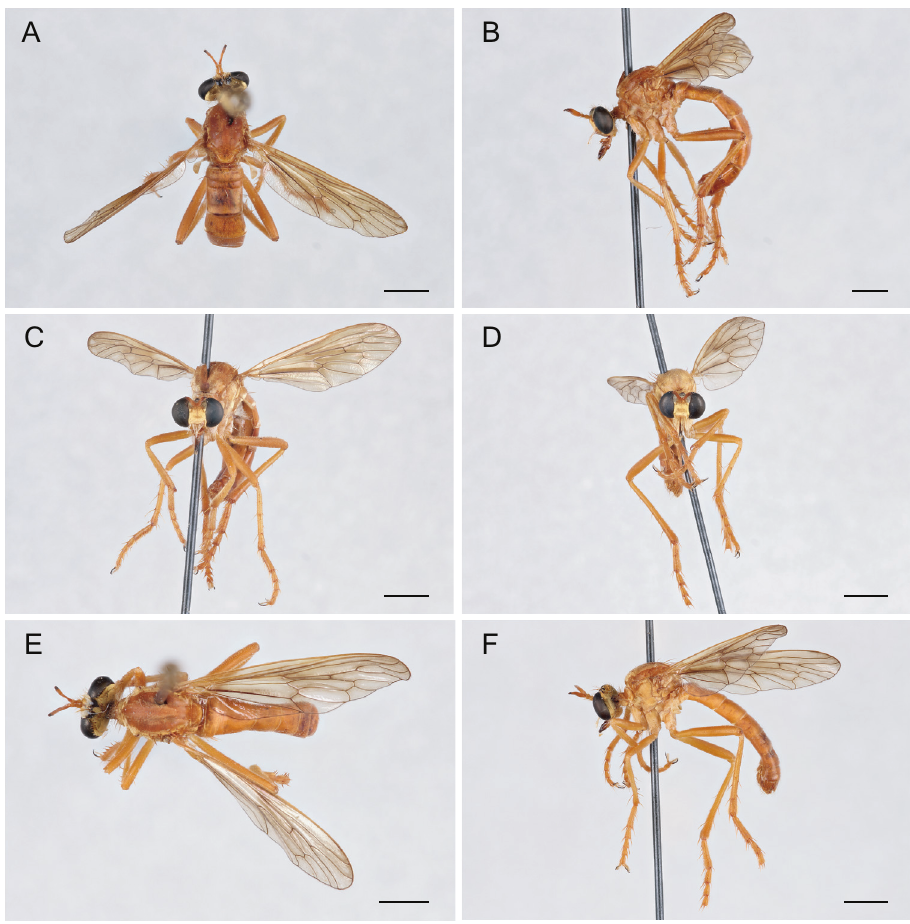
Figure 17. Saropogon luteus Coquillett, 1904 Female (UCBMEP0073792): A dorsal view B lateral view C anterior view; Male (UCBMEP0073760): D anterior view E dorsal view F lateral view. Scale bars: 2